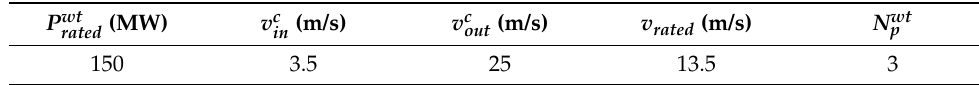
Table 3. Parameters for the wind turbine.